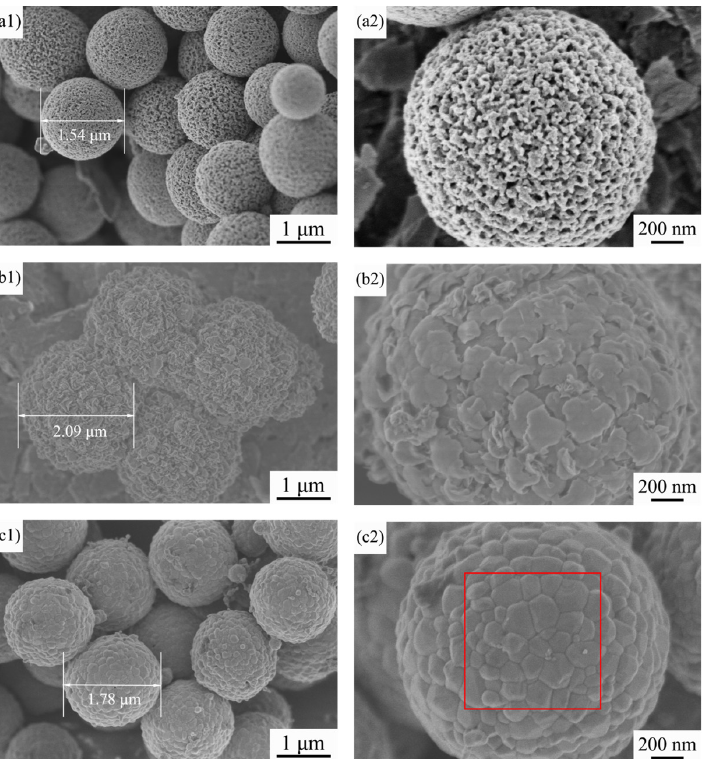
Figure 4. FE-SEM images of ( a1 , a2 ) the home-made TiO 2 precursor microspheres, ( b1 , b2 ) the inter- mediate microspheres at a Co/Ni molar ratio of 0.5:0.5 and ( c1 , c2 ) the composite pigment powder obtained after calcination of the powder in ( b1 , b2 ) at 800 °C.